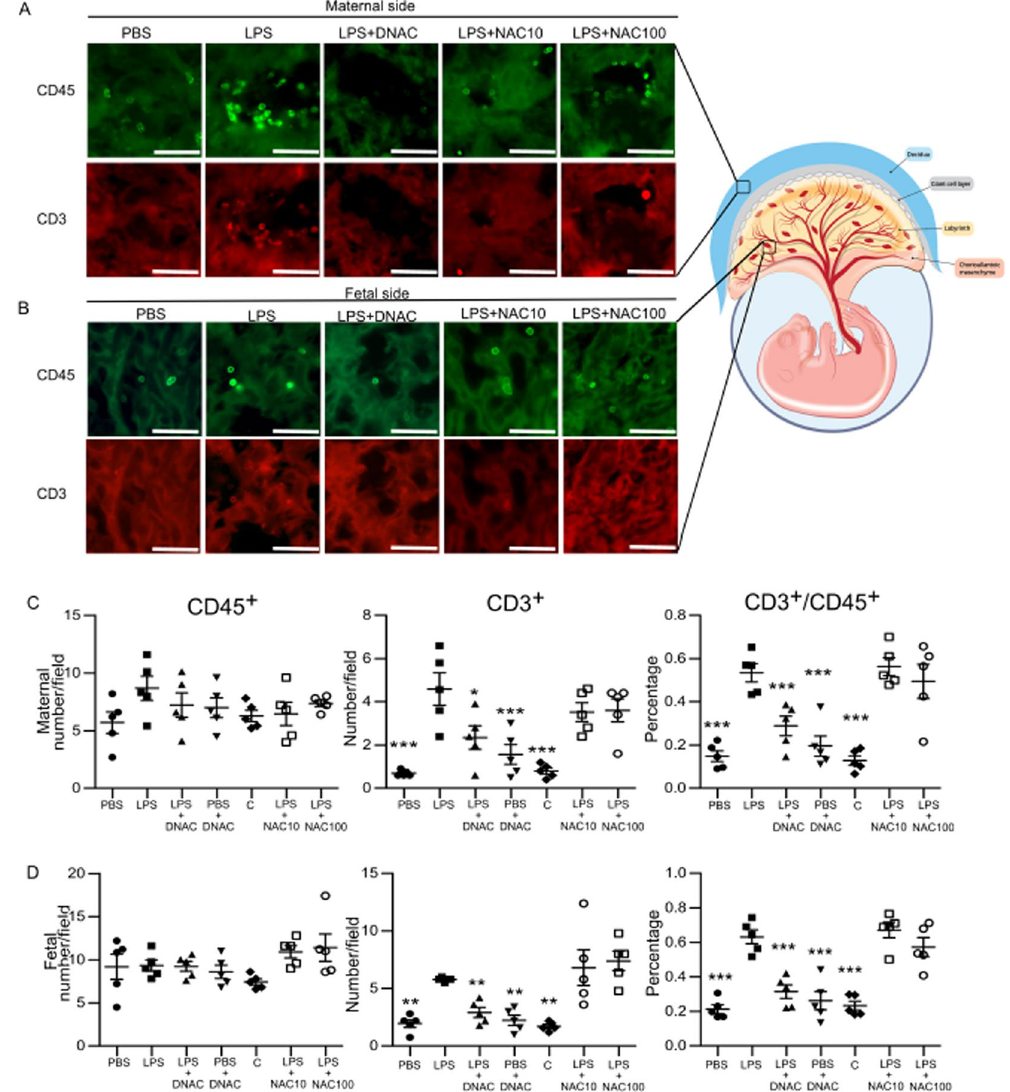
Figure 3. DNAC suppresses CD3 + T- cell recruitment to the placenta. ( A , B ) Placentas were collected at 6 hours after intrauterine LPS injection and stained with anti-CD45 (a marker for hematopoietic cells) and anti-CD3 (a marker for T cells) antibodies. DAPI staining identified nuclei. CD45 + and CD3 + cells were quantified in the maternal and fetal sides of the placenta (vasculature excluded). CD3 + /CD45 + cells were observed at the margins of vessel walls in LPS group. This phenomenon was not observed in the other groups evidently. The diagram was printed with permission © 2016 Jennifer Fairman, CMI, Johns Hopkins University SOM. ( C , D ) LPS increased CD3 + cells and ratio of CD3 + /CD45 + cells in both the maternal and fetal sides of the placenta compared to PBS and DNAC groups ( * p < 0.05, ** p < 0.01 and *** p < 0.001 vs. LPS; One-Way ANOVA with Bonferonni post-hoc test, n = 5 for all groups (7 groups, 35 litters)). Images are 40 × magnification, and scale bars represent 50 µ